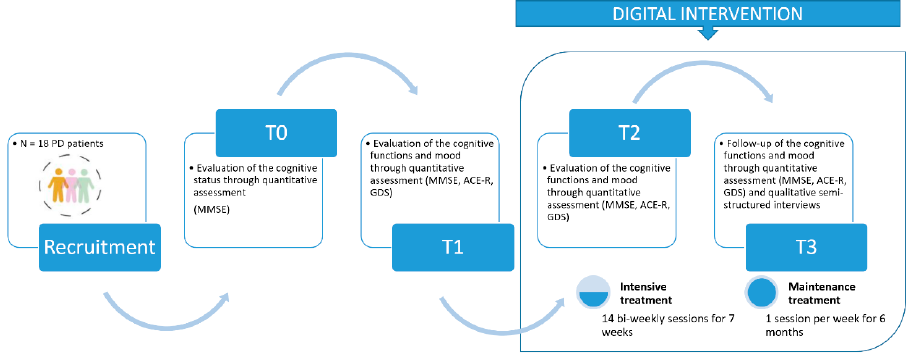
Figure 1. Study design